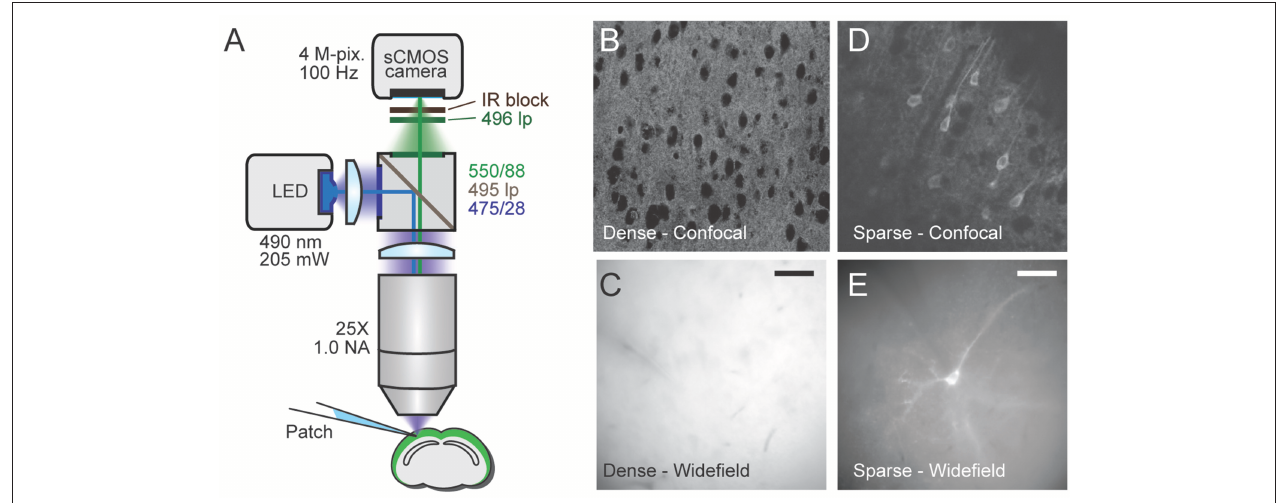
FIGURE 1 | Comparison of densely and sparsely expressed GEVIs. (A) The microscope set up for wide-field imaging. We used a standard epifluorescence microscope configuration to image patched cells expressing GEVIs in sparsely and densely expressing brain slices. (B) A confocal image of a brain slice densely expressing chimeric VSFP-butterfly. Assignment of fluorescence to individual neurons is impossible due to expression in overlapping membranes. (C) A wide-field image of a brain slice with the same expression strategy. The problem of assignment is compounded by the lack of optical sectioning, making even cell bodies difficult to discern. (D) A confocal image of a brain slice sparsely expressing VSFP butterfly via destabilized-Cre modulated expression. Processes and soma from individual GEVI-expressing cells can be clearly resolved. (E) Wide-field image of a brain slice with the same expression strategy. Contrast is decreased due to lack of optical sectioning, but single cells and processes can still be resolved. Scale bar 40 µ m.